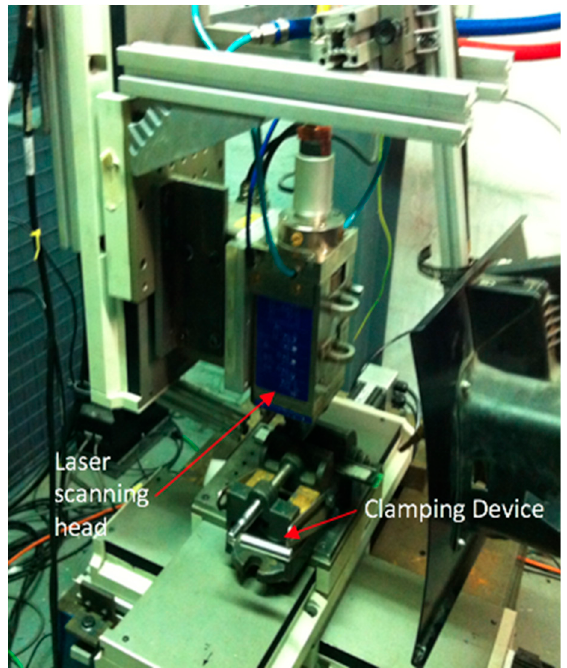
Figure 2. Variation of Ø spot sizes overview window’s scale for Precitec HP1.5” (adapted from Reza [15]).